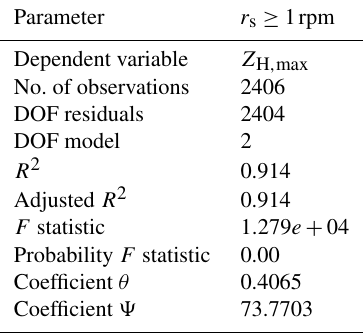
Table 6. OLS (ordinary least square) regression results for fitting Z H , max by the independent variables θ and (cid:57) . The results are shown for the normal WT operation with rotor speeds r s ≥ 1rpm. DOF denotes degree of